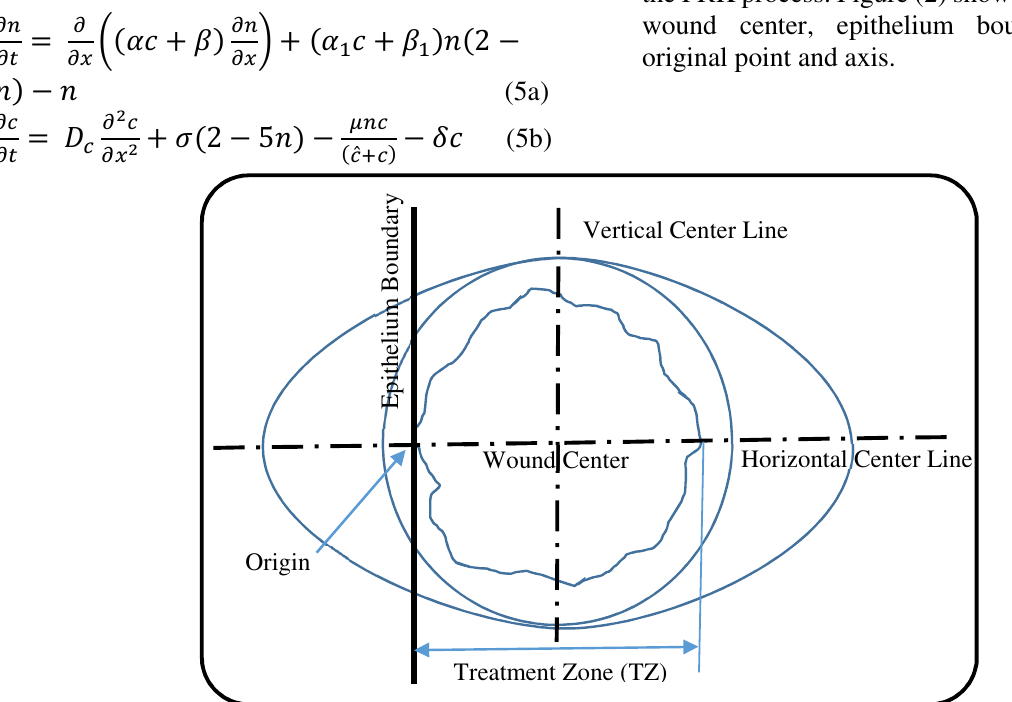
Fig. 2. Important notification on the human eye sketch.